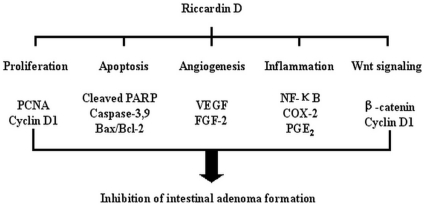
Summary for the pathways inhibited by Riccardin D in APCMin/+ mice intestinal polyps.